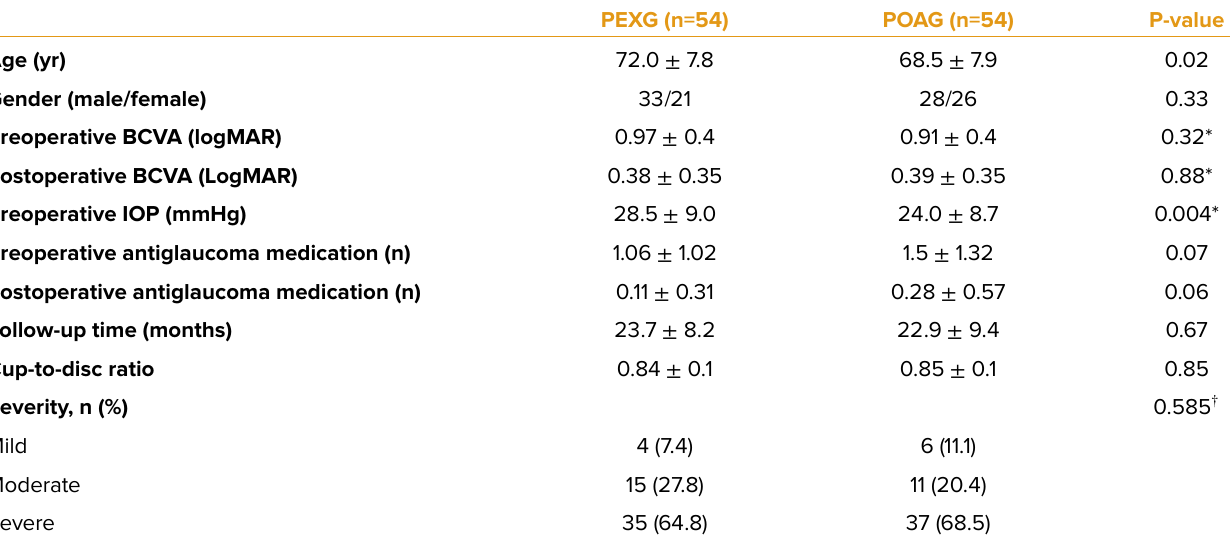
Table 1. Demographic data, baseline, and postoperative data at final follow-up visit in the study groups